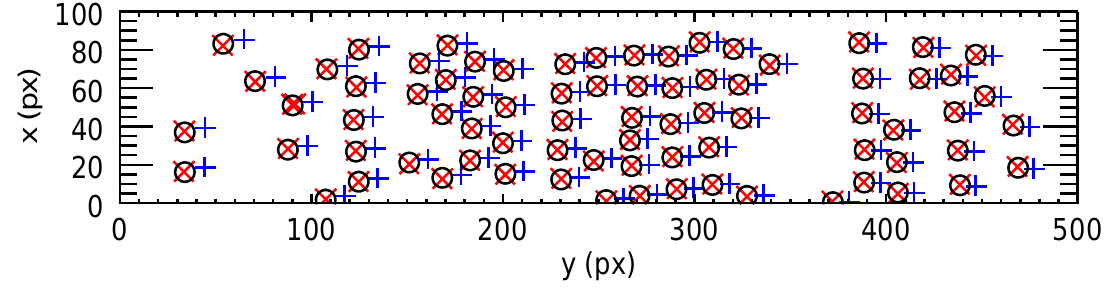
Figure 5. Red crosses: Particle positions in the overlap region in the left image (Camera 1), coordinates given with respect to the bottom left corner of the cropped region. Blue plus signs: Particle positions in the overlap region in the right image (Camera 2), translated only along x with the initial guess value t xmi = − 3 px. Black circles: Particle positions from the right image translated with the least squares fit parameters (Equations